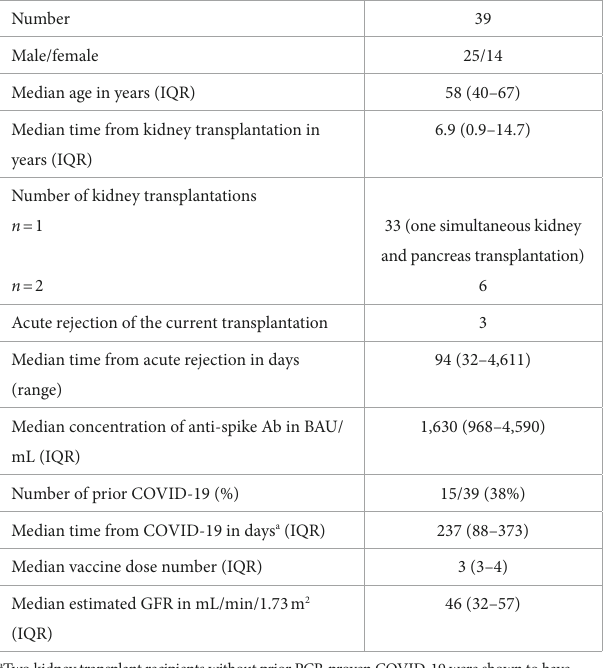
to have positive serology against the nucleocapsid protein, suggesting